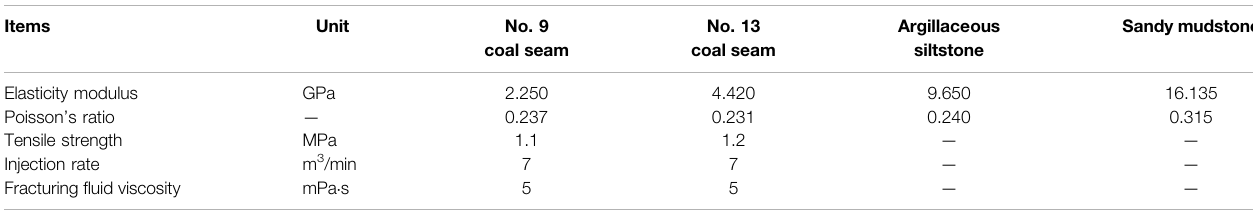
TABLE 1 | Basic parameters of the model.